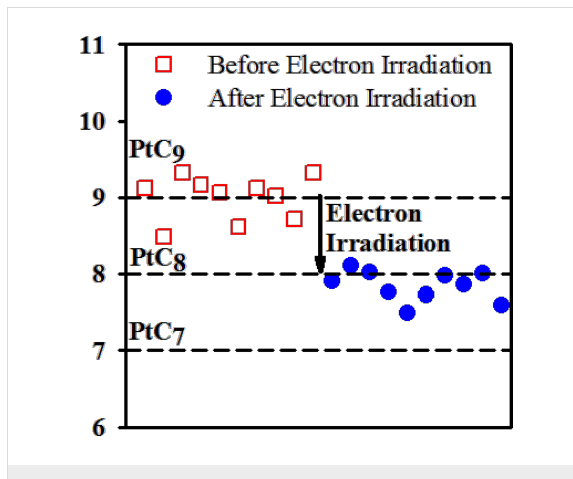
Figure 10: Changes in the C/Pt ratio of a 3.16 nm thick film of MeCpPtMe 3 adsorbed on a gold surface at 180 K (reproduced with permission from Wnuk et al. [21], Copyright (2009) American Chem- ical Society). The open squares show the C/Pt ratio before electron ir- radiation and filled circles show the C/Pt ratio after irradiation with 500 eV electrons. The dashed horizontal lines indicate the expected C/Pt ratio for films with stoichiometry of PtC 9 , PtC 8 and PtC 7 .